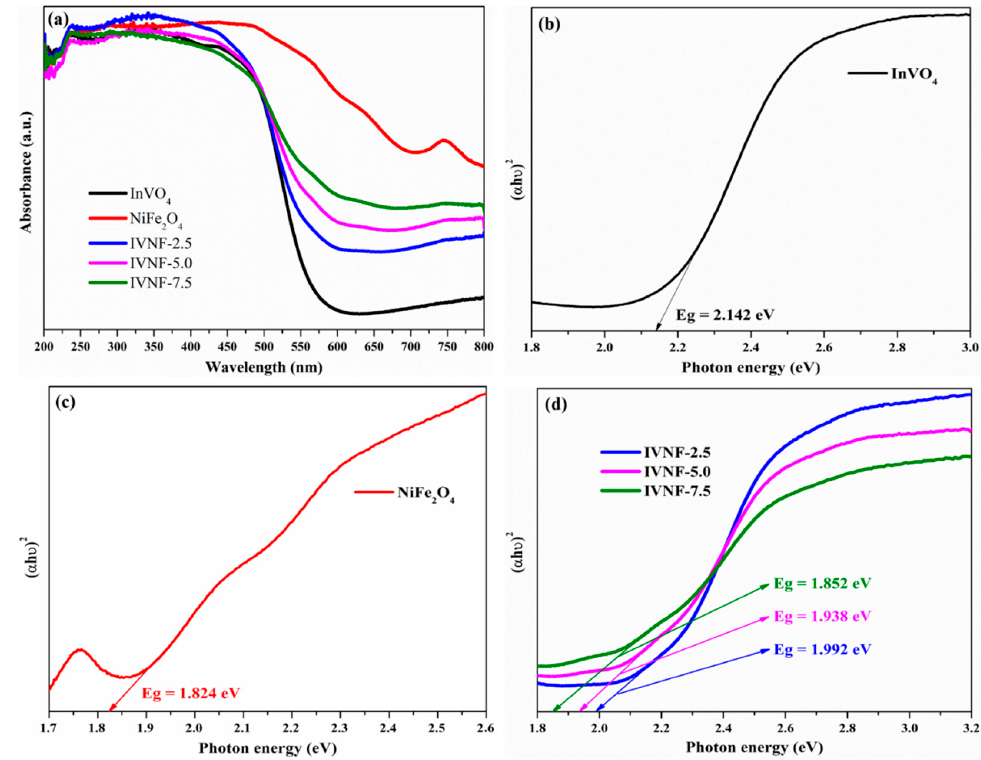
Figure 6. ( a ) Optical absorption spectra and ( b – d ) Tauc plots of the synthesized